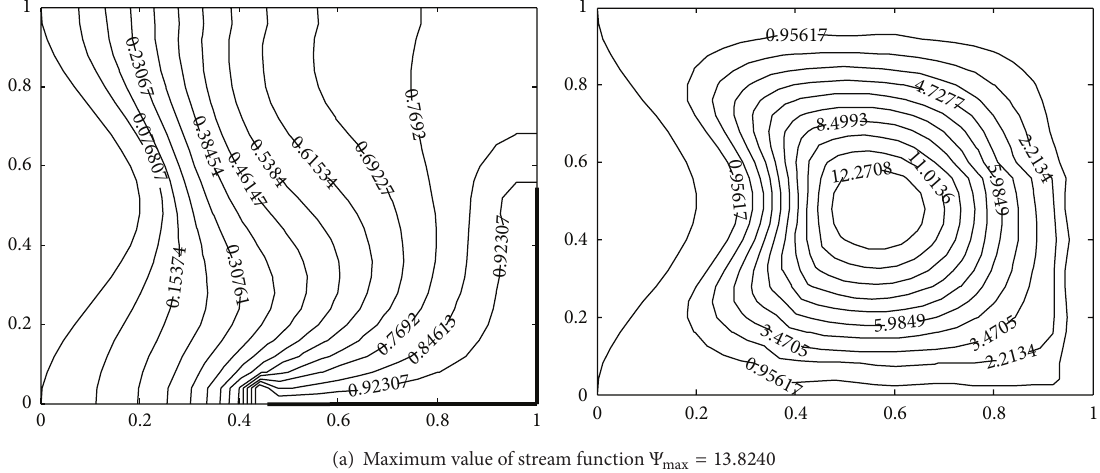
(a) Maximum value of stream function Ψ max = 13.8240